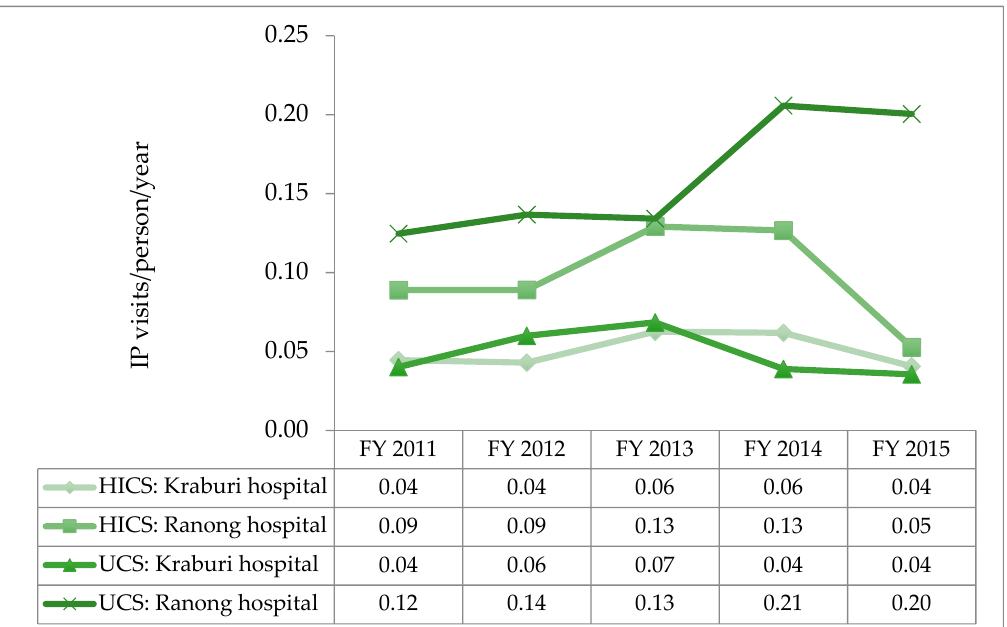
Figure 4. IP utilisation rates between the Health Insurance Card Scheme (HICS) and the Universal Coverage Scheme (UCS) beneficiaries by years.